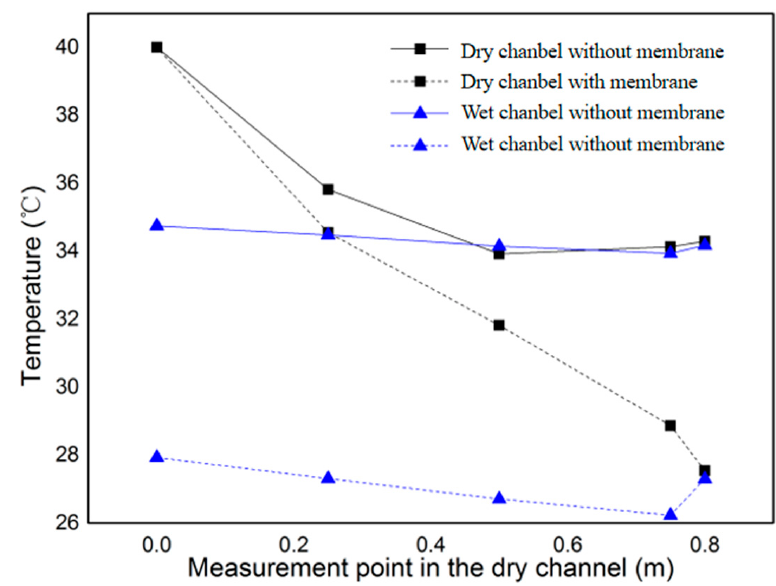
Figure 7. Temperature tendency inside the wet and dry channels.